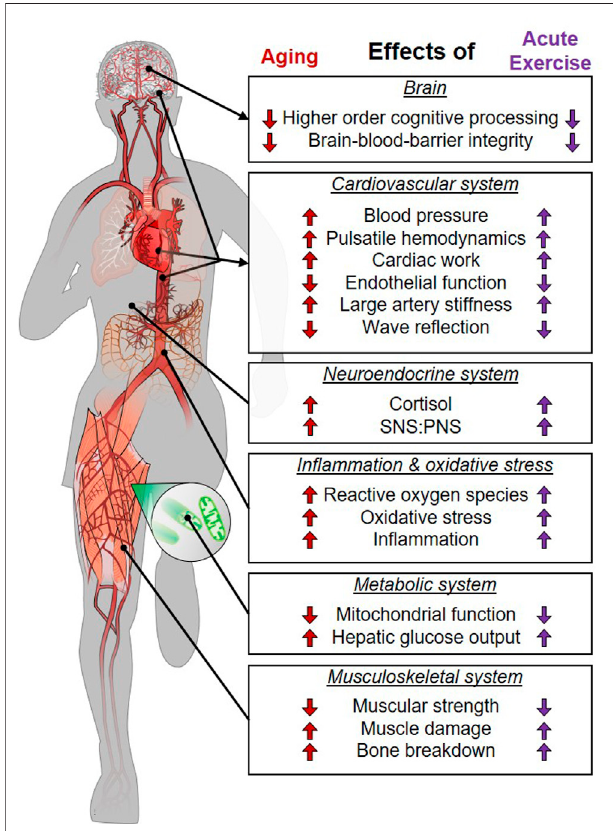
FIGURE 1 | Parallels between the stress of aging/chronic disease and acute physical exercise. SNS, sympathetic nervous system; PNS, parasympathetic nervous